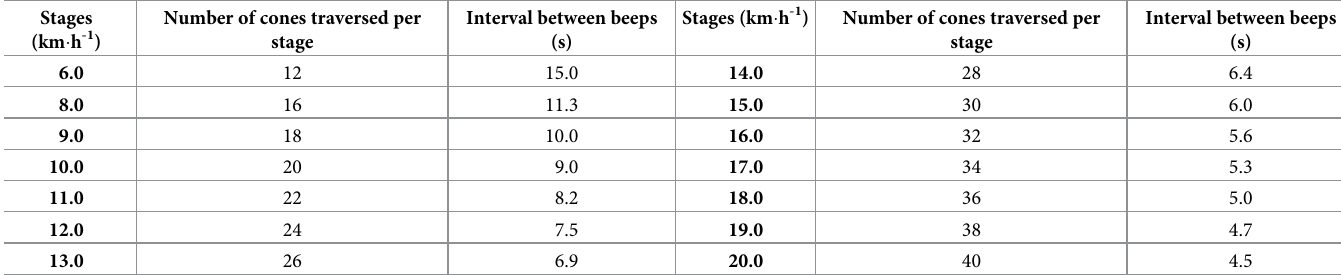
Table 1. Test characteristics for determination of V peak on the track field (V peak_TF ). Stages Number of cones traversed per (km � h -1 )